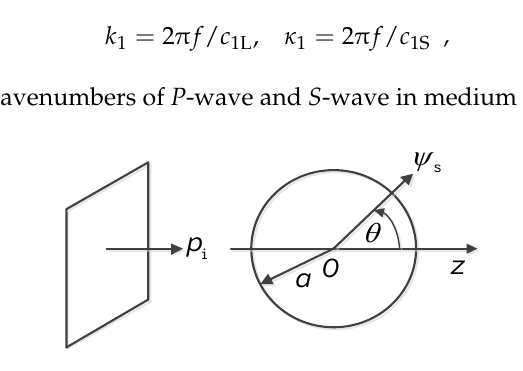
Figure 2. Scattering model of a void in elastic solid.